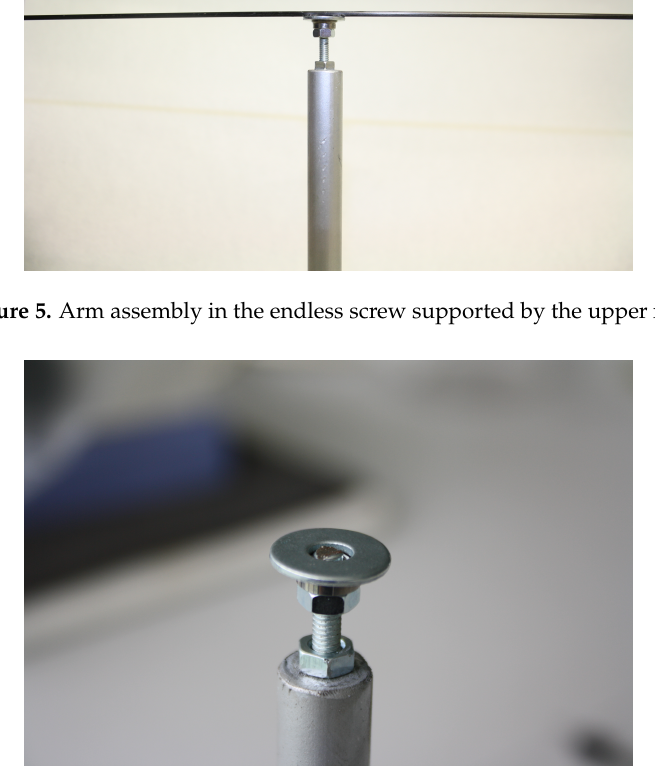
Figure 6. Detail of the washer-ball bearing assembly supported by the nut, without the arm.